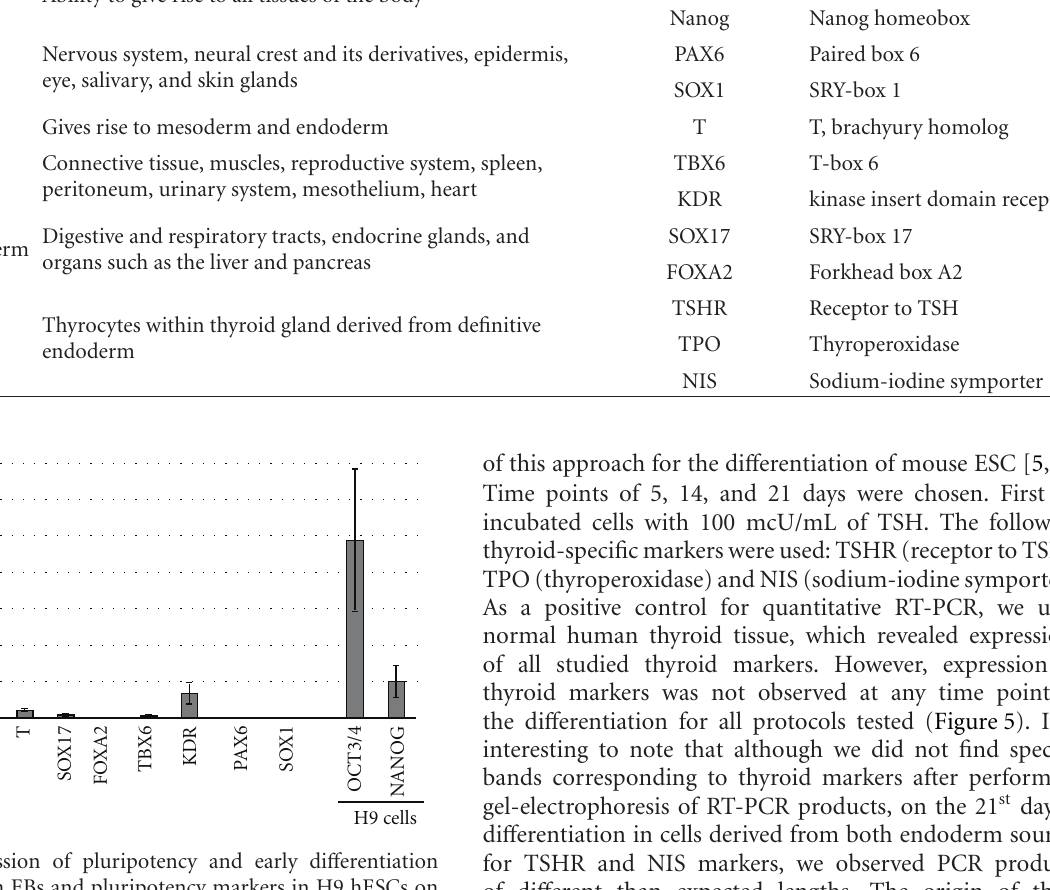
Table 1: Markers and their description indicating pluripotency, three germ layers, and thyroid tissue. Pluripotency